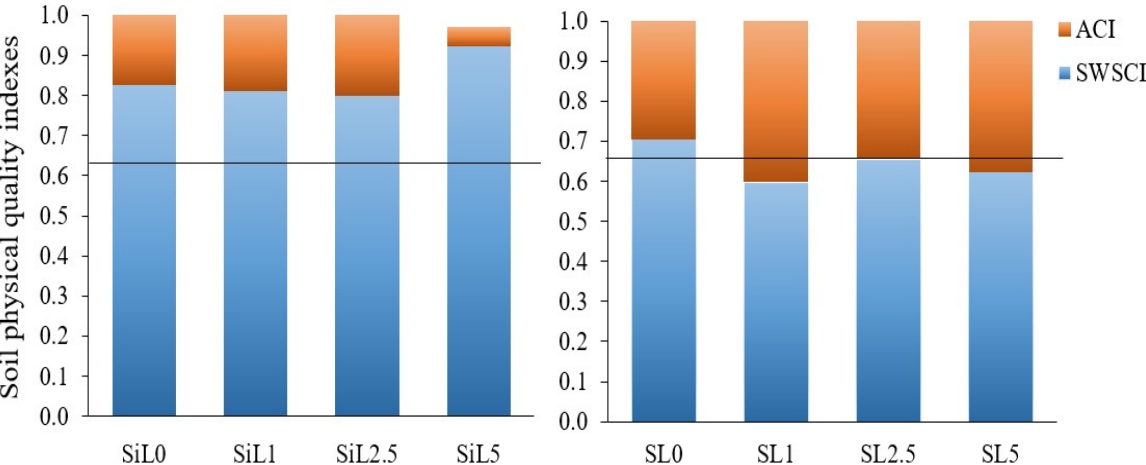
Figure 6. Soil Water Storage Index (SWSCI) and Air Capacity Index (ACI) for the silt loam (SiL) and sandy loam (SL) mixtures. The horizontal continuous line represents limit index values suggested by Reynolds et al. [41].